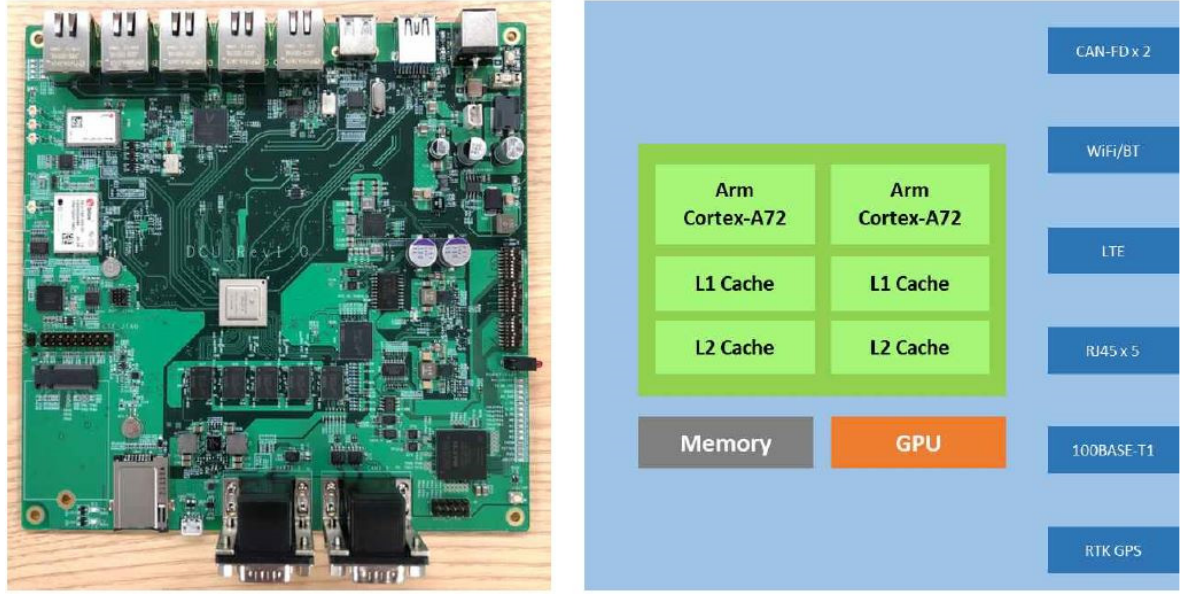
Figure 6. Hardware platform of the fusion system.